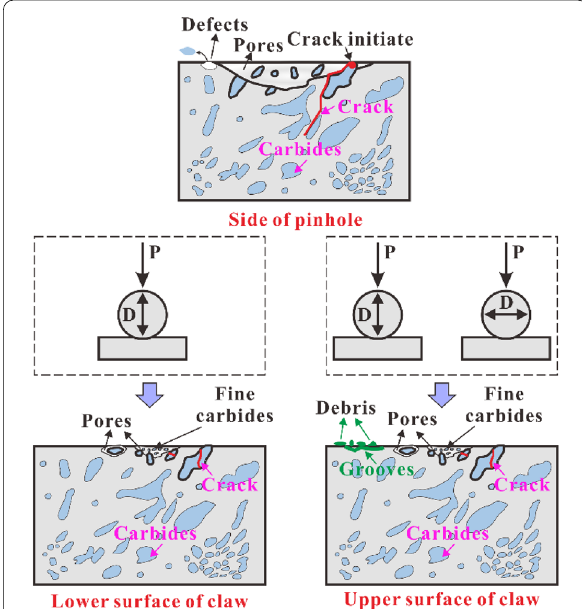
Figure 14 Degradation mechanism of movable latch in various